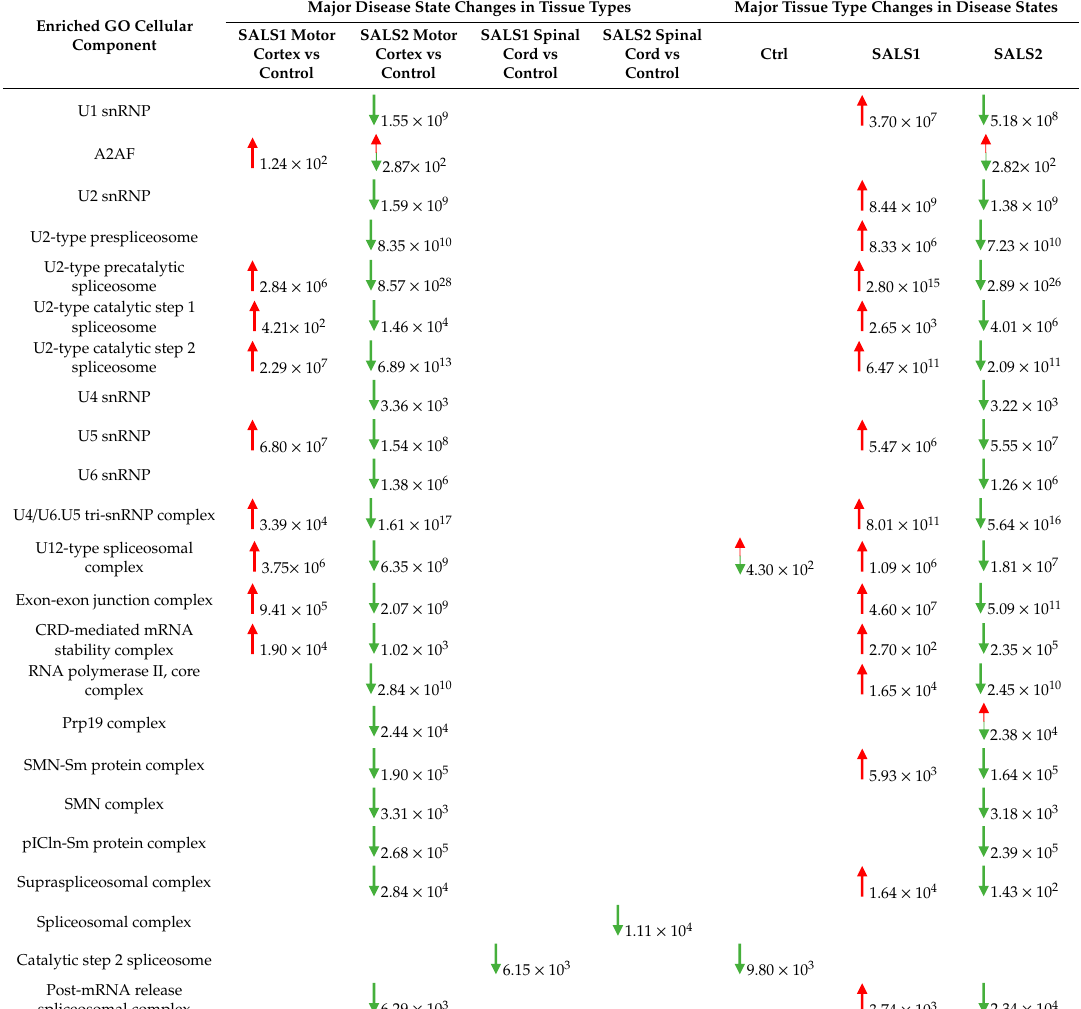
Table 2. Enriched gene ontologies (GOs) of differentially expressed genes (DEGs) in both disease state and tissue types pairwise comparisons. Enriched GO Cellular Component Major disease state changes in tissue types